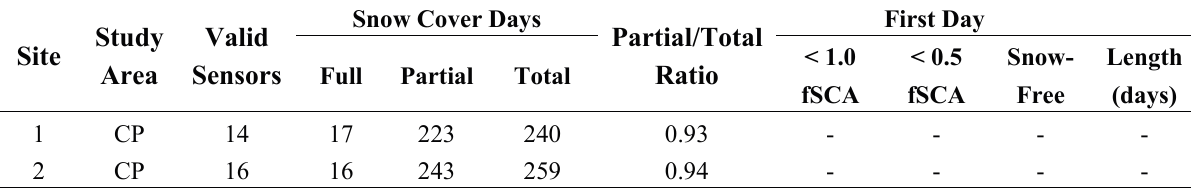
Table 5. Full, partial, and total snow cover days, as well as snow-covered to snow-free transition period metrics for 60 × 60 m footprints. Transition period metrics were not calculated for sites with intermittent winter snow cover. CP indicates Cinnamon Pass, while NR indicates Niwot Ridge. fSCA indicates fractional snow-covered